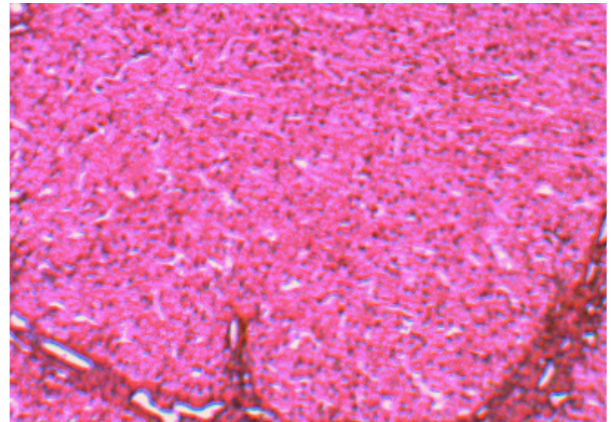
Figure 2: Liver biopsy showing ectactic bile ducts, portal to portal fibrosis but intact lobular architecture and central vein (HE stain X